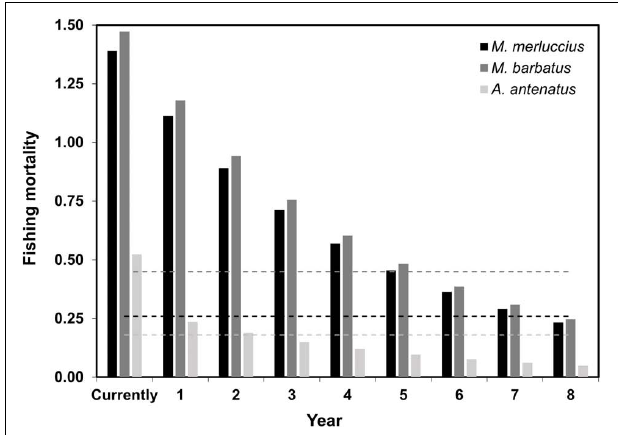
FIGURE 2 | Fishing mortality values with an effort reduction of 20% per year for A. antennatus , M. barbatus , and M. merluccius . Dashed lines indicate the F MSY levels ( M. merluccius , 0.26; M. barbatus , 0.45; A. antennatus ,